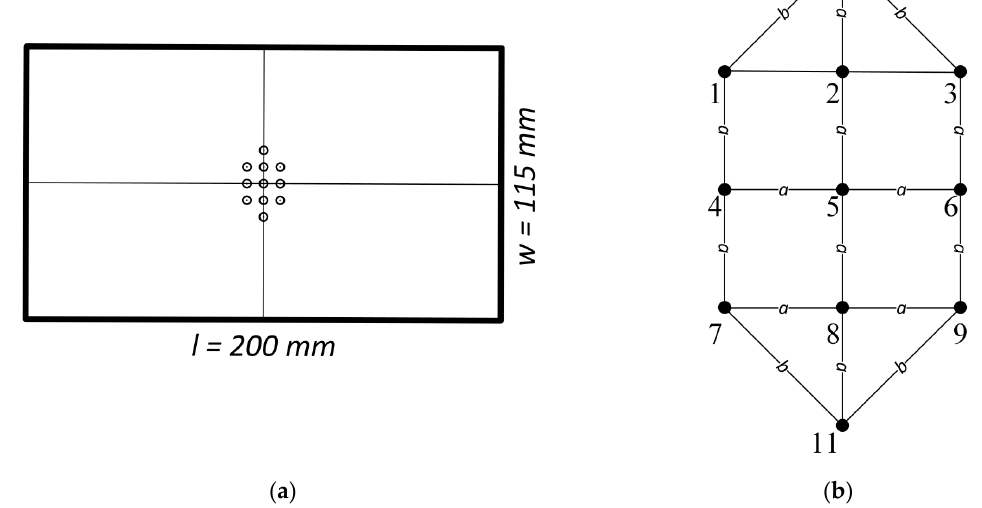
Figure 4. The spatial configuration of the measurement points on the specimen with the presence of corrosion cracks ( a ) and distribution of measurement points in the region of interest ( b ).